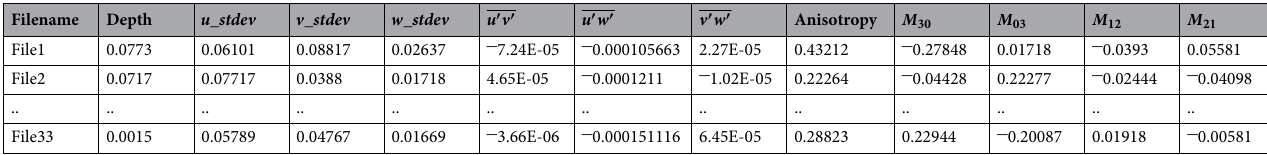
Table 6. Statistical parameters of turbulence obtained via P-SAT (Continued...).